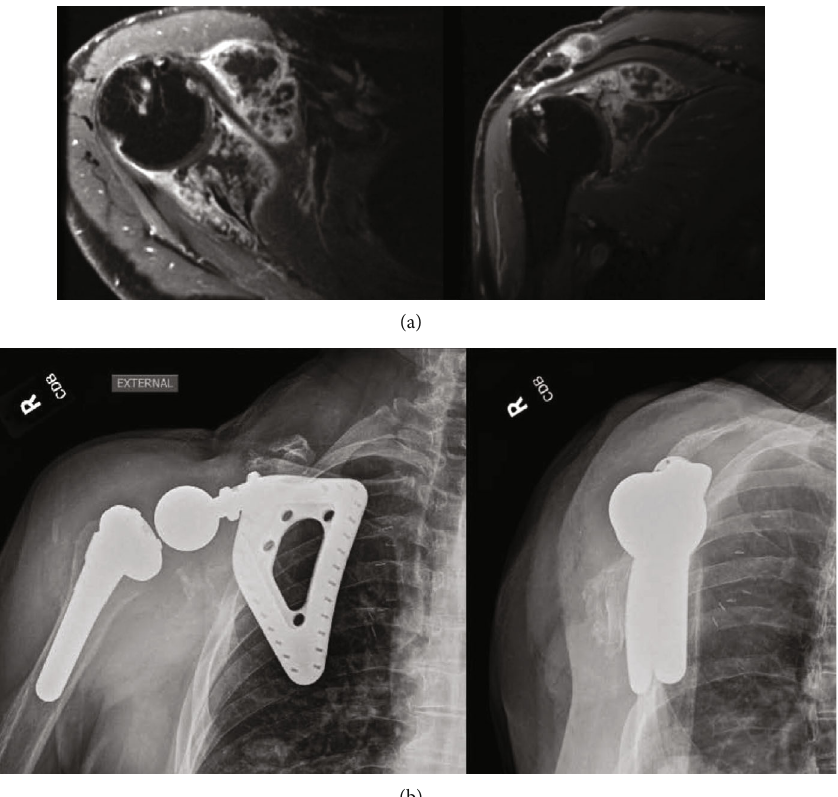
Figure 1: (a) MRI demonstrating expansive, in fi ltrative soft tissue malignancy about the scapula and shoulder girdle. (b) Eight-month postoperative radiographs demonstrating well- fi xed implants in appropriate